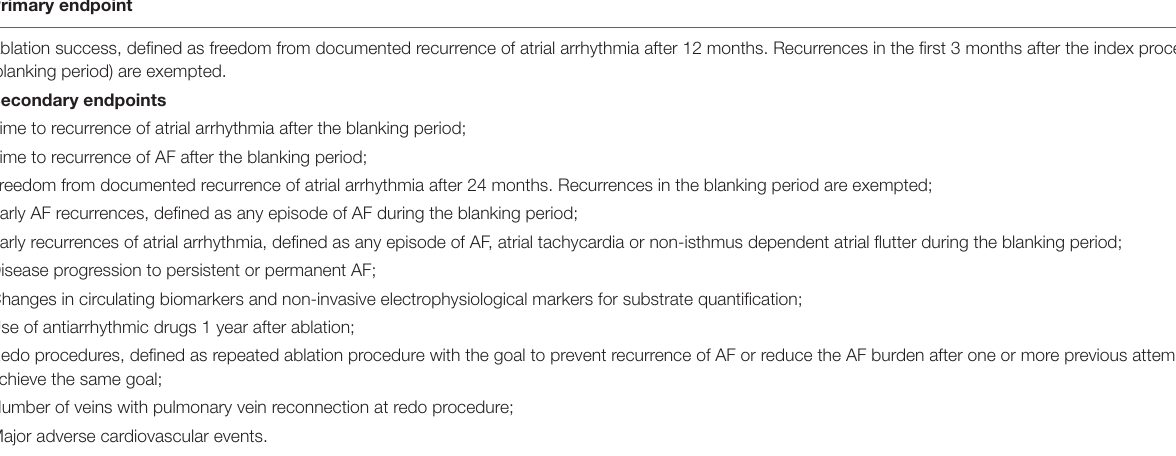
TABLE 2 | Primary and secondary endpoints in the ISOLATION